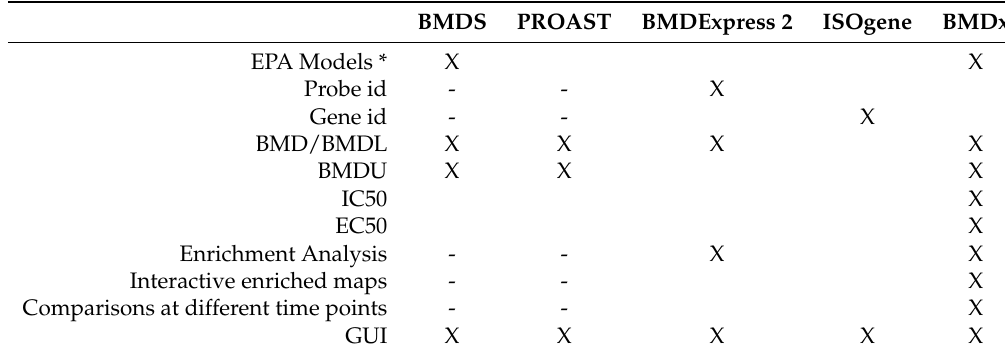
Table 1. Tools available for benchmark dose analysis. BMDS PROAST BMDExpress 2 ISOgene BMDx EPA Models * Probe id - Gene id